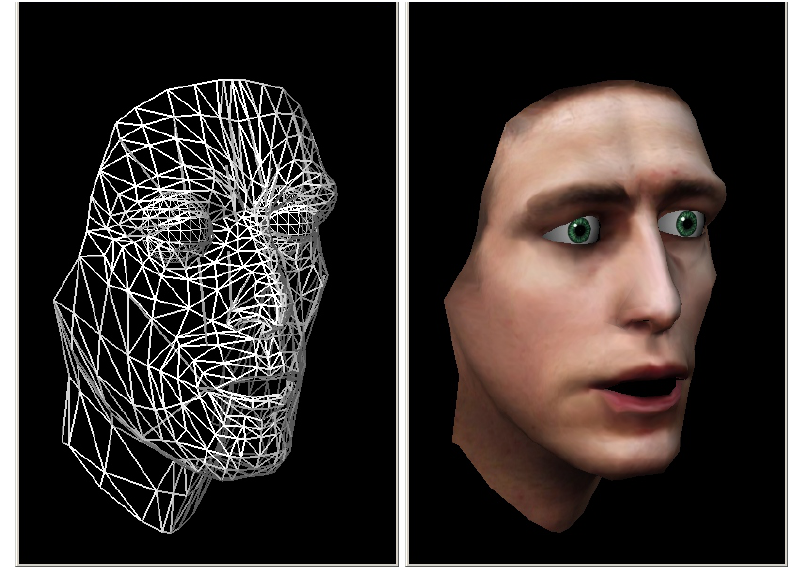
Figure 11. Geoface head